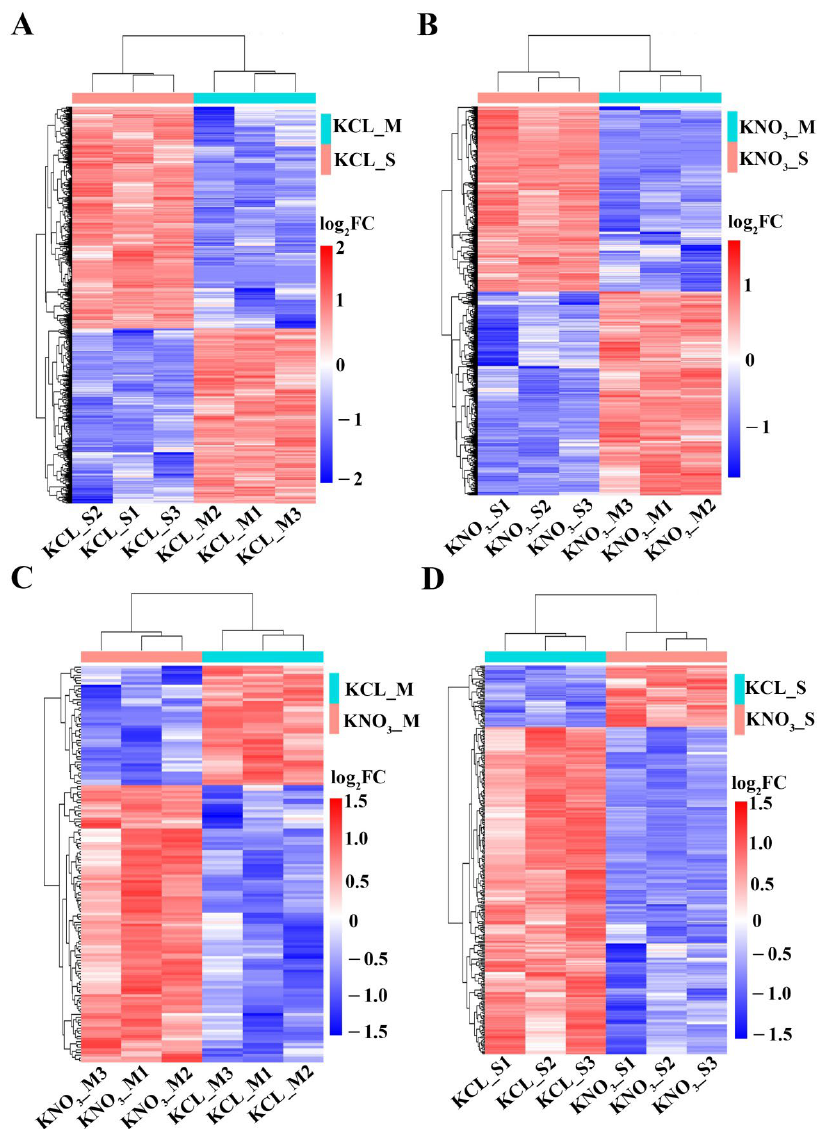
Figure 2. Clustering analysis of the differentially expressed genes. ( A ) Clustering analysis of DEGs identified from comparison group of S and M treated with KCL. ( B ) Clustering analysis of DEGs identified from comparison group of S and M treated with KNO 3 . ( C ) Clustering analysis of DEGs identified from comparison group of M treated with KNO 3 and KCL. ( D ) Clustering analysis of DEGs identified from comparison group of S treated with KNO 3 and KCL.